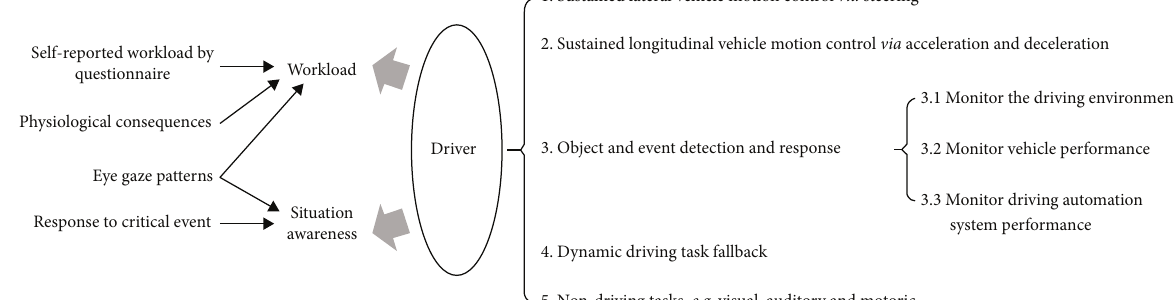
Figure 1: Schematic view of the driver’s tasks in L0 ∼ L5 and measurements of the driver state. Note that (1) nondriving tasks (task 6) do not include those (turning a radio, scanning road signs, answering the phone, etc.) that only require short periods of eyes-off-road time and can be performed simultaneously with driving tasks; (2) strategic tasks (i.e., navigation), such as trip scheduling and route following, were not listed because the difference among automation levels does not include strategic aspects of